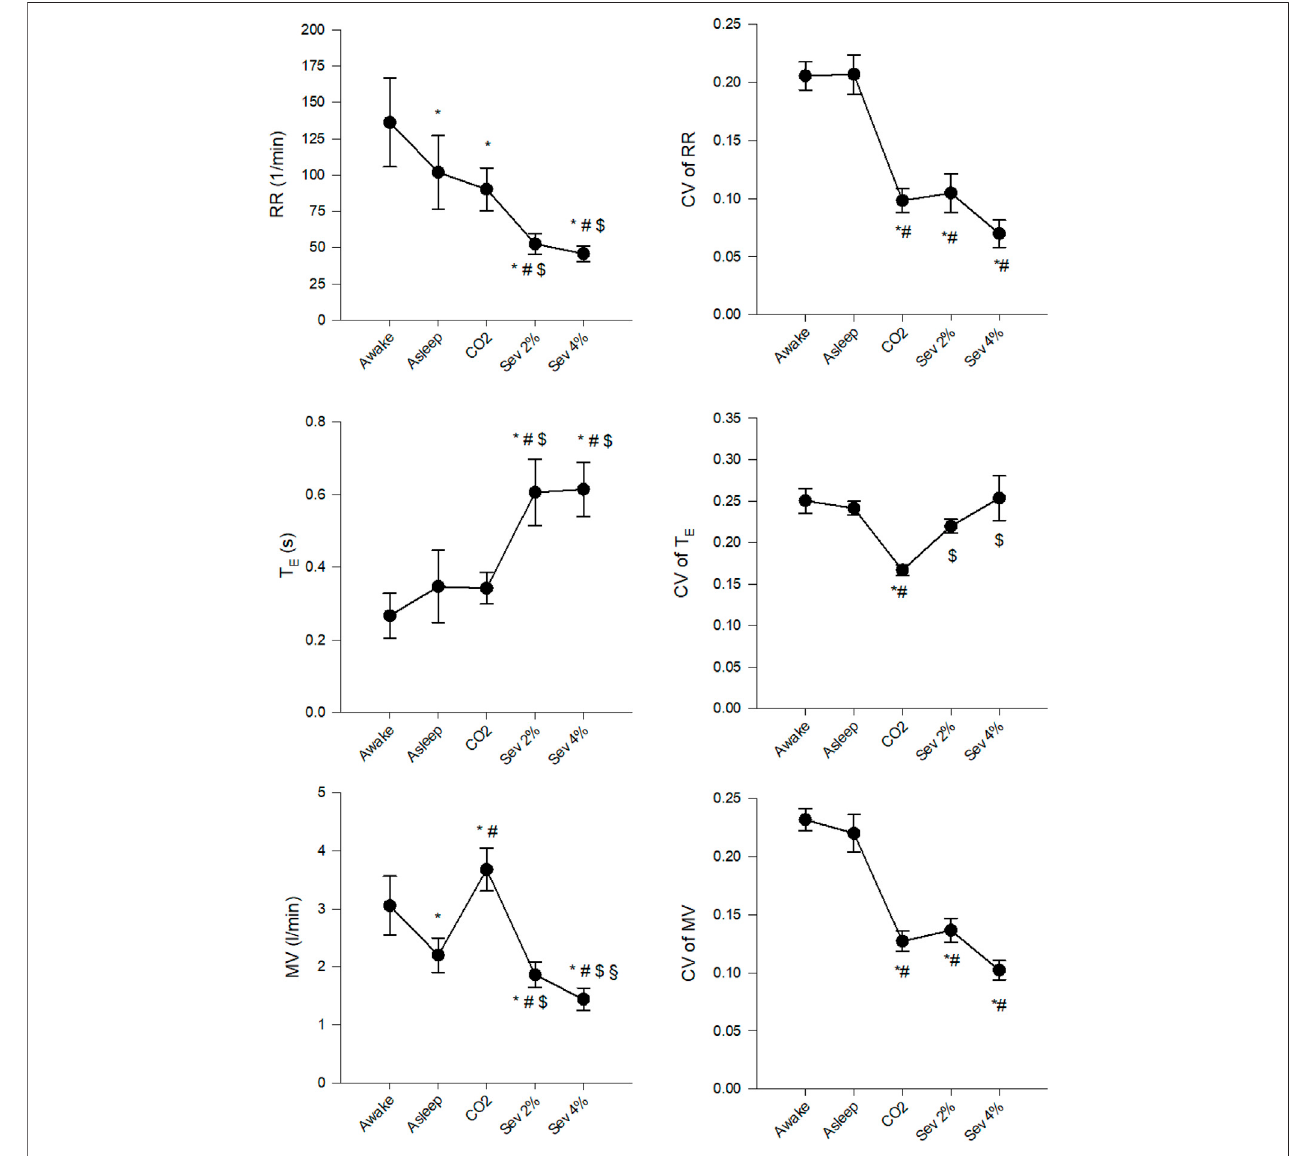
FIGURE3| Changesintheabsolutevaluesandcoef fi cientsofvariation(CV)ofrespiratoryrate(RR),expiratorytime(T E )andminutevolume(MV)inwakeful(Awake) and sleeping (Asleep) rabbits and during the inhalation of 5% CO 2 (CO 2 ) or 2% sevo fl urane (Sev 2%) or 4% sevo fl urane (Sev 4%). * p < 0.05 vs. Awake, # p < 0.05 vs. Asleep, $ p < 0.05 vs. CO 2 , § p < 0.05 vs. Sev 2%.